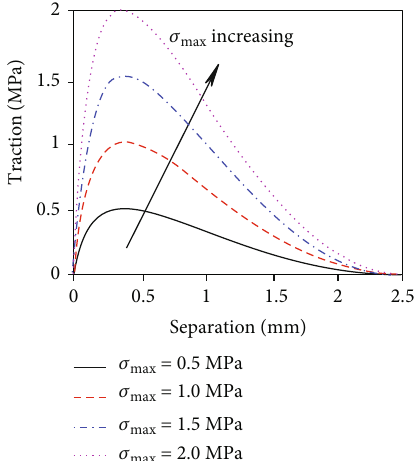
n , 5: Response under di ff erent cohesive strength σ : 5mm , m = 0 : 1672 , α = 3 : 10 [40]. Δ c n = 2